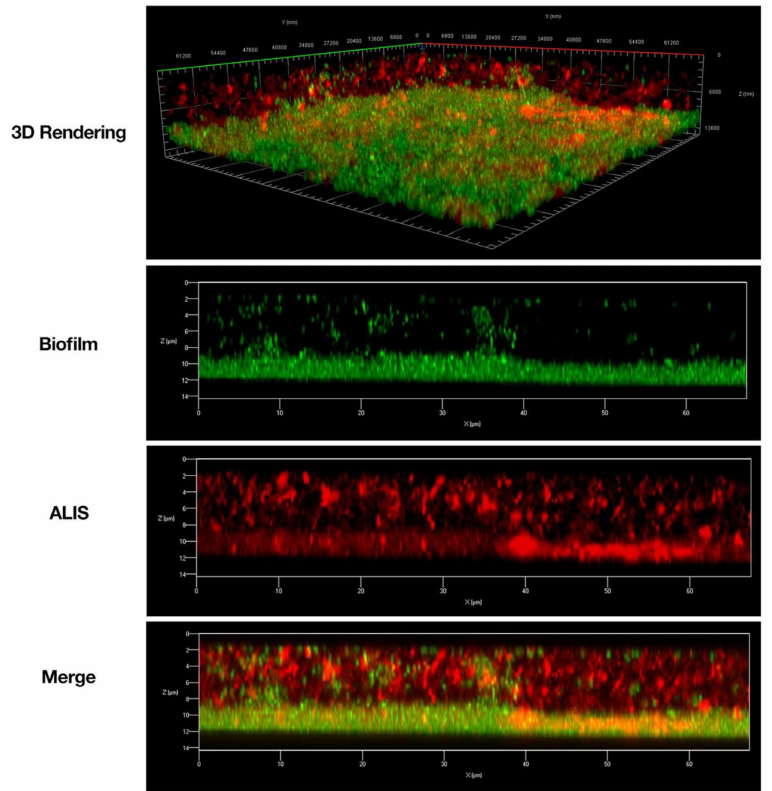
Figure 7. Amikacin liposome inhalation suspension (ALIS) penetrated Mycobacterium avium biofilms. Biofilms (strain A5) were established for 7 days in 2-well chamber slides, treated with 512 µ g/mL of AF657-labeled ALIS (red) for 4 h, fixed, stained with Syto9 (green), and imaged with a Zeiss LSM 780 confocal scanning microscope (630 × magnification). Adapted from [149]. Frontiers,